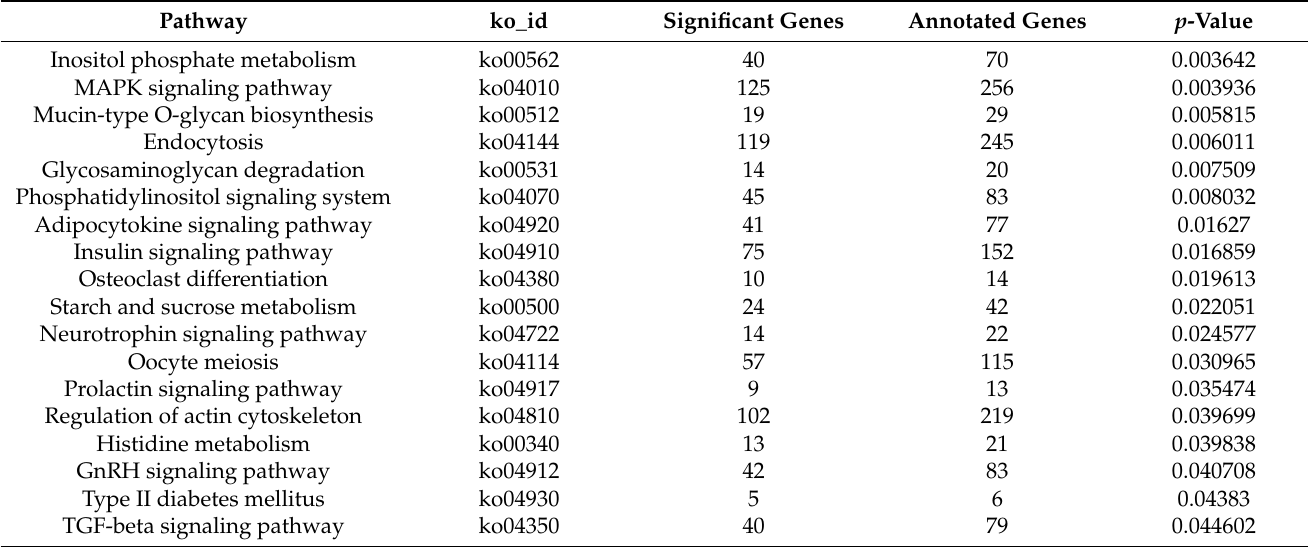
Table 2. KEGG pathway enrichment analysis of the DEGs in the gonadal tissues of male and female Andrias davidianus